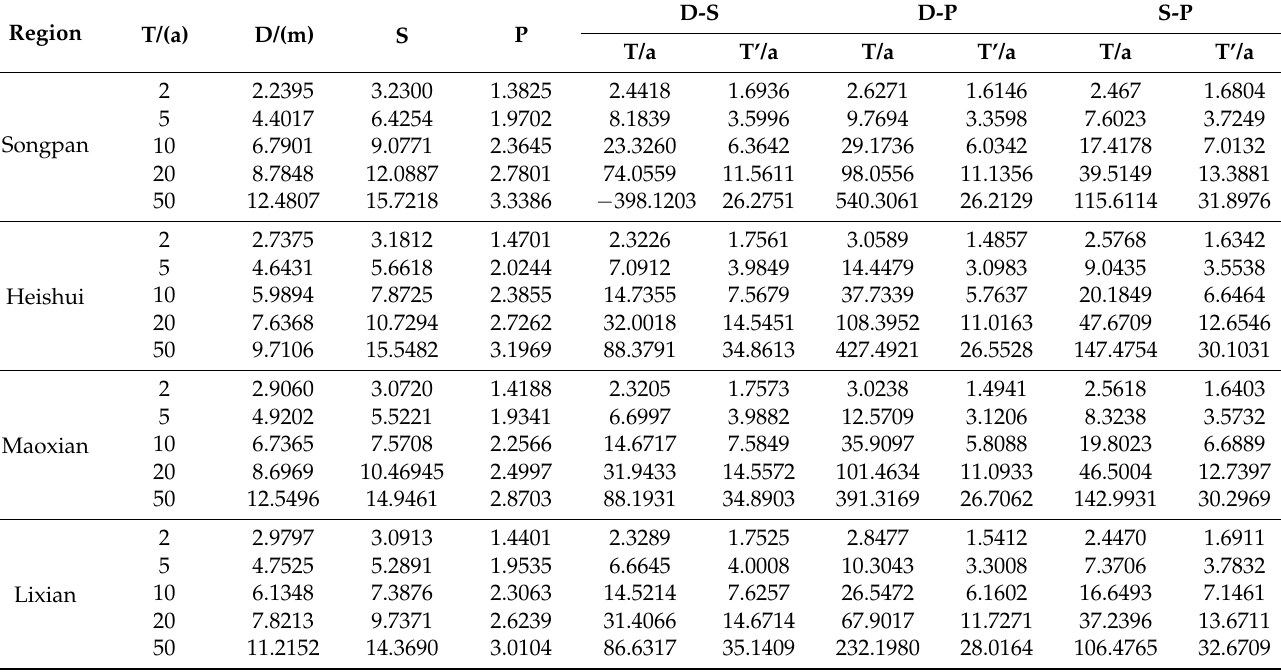
Table 8. Return periods of joint distribution of drought